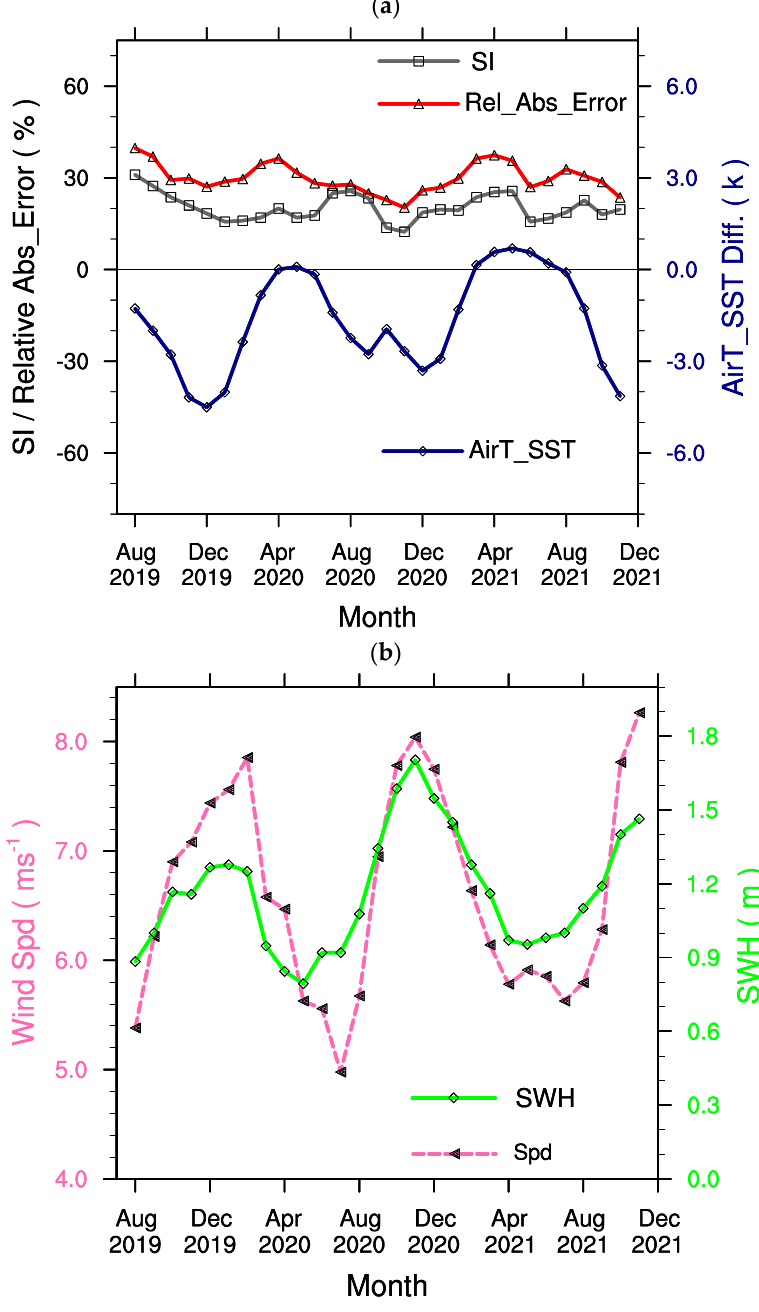
Figure 3. The variance of RAE and SI of CFOSAT SWH with in situ observations ( a ), where the RAE (red line) is defined in Section 2.4. The temporal and spatial windows are set to 30 min and 50 km, respectively. The RAEs of 23 buoys were used to calculate the monthly mean. The air − temperature and sea − surface − temperature differences (blue line) have a significant correlation with the RAE at the 95% confidence level as observed in ( a ) but for variance of sea − surface wind speed and SWH ( b ). The temporal − correlation coefficient between the SWH from the buoys (( b ), green line) and the monthly mean RAE is −0.73 ( statistically significant at the 95% confidence level). The Scatter Index (( a ), gray line) and wind speed from the buoys (( b ), pink line) are the monthly mean of 23 buoys in a month. Usually, from October to May, temperature inversions appear mostly in the air – sea interface layer along the southeastern coast of China, in the west and south of the Korean Peninsula, and in the north and east of the Shandong Peninsula [48]. It is worth noting